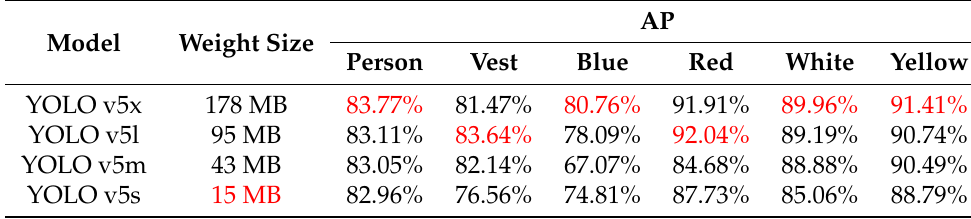
Table 6. Correctness and weight size of YOLO v5 models.